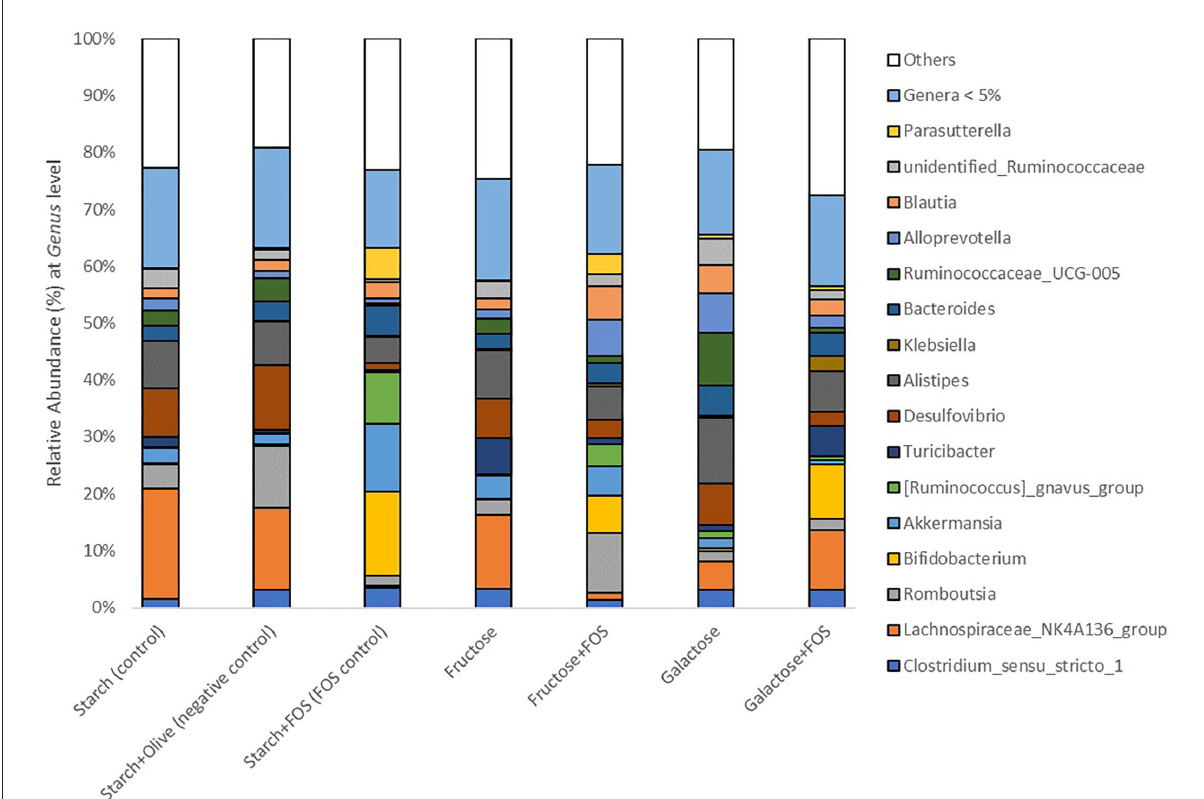
FIGURE3 Gut microbiota composition (relative abundance, %) at phylum level in rats fed a control diet (starch, starch + FOS, starch + olive) or a high-fructose or high-galactose diet, with and without added fructooligosaccharides (FOS), after 12 weeks. Only classified genera with relative abundance above 5.0% cut-off level are shown. White bars indicate all genera with mean relative abundance <